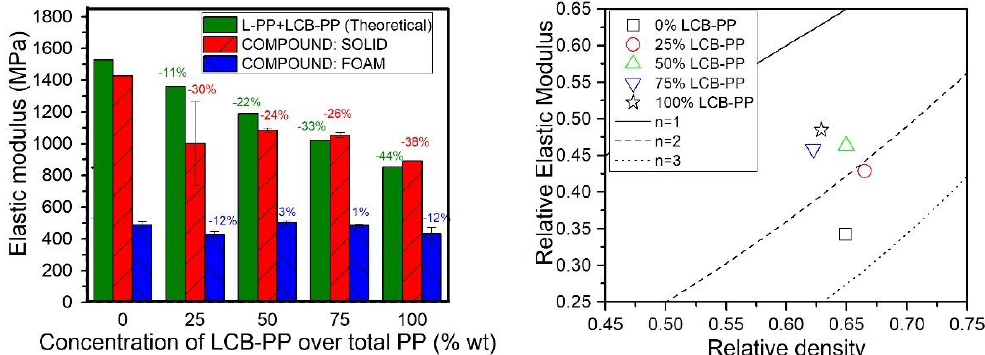
Figure 6. Tensile elastic modulus of solids samples and foams ( left ) and relative elastic modulus of foams in the scale model representation ( right ). The theoretical elastic modulus of a blend of L-PP and LCB-PP using the model expressed in Equation (4) is represented in the left graph. The percentages in the left graph indicated the percentage of variation of the elastic modulus of each sample with respect to the 0% LCB-PP compound value, for solids ( red ) and foams ( blue ).